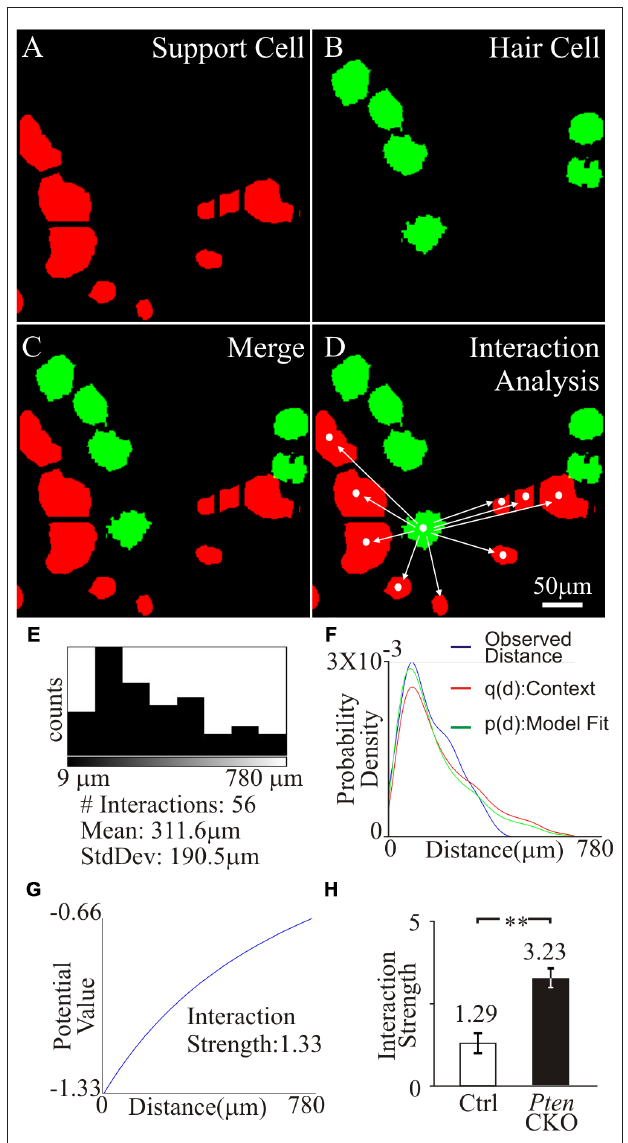
FIGURE 7 | Interaction strength of supporting cell and surviving hair cells. Region containing tdTomato+supporting cell and MYO7A+ tdTomato- hair cells were analyzed. (A) Supporting cell masks were generated from tdTomato labeled supporting cells (red). (B) Hair cell masks were generated from MYO7A labeled hair cells (green). (C) Merged image of supporting cell and hair cell masks. (D) Centroid of hair cell and supporting cells were generated from masks. Distance between an individual hair cell centroid to all supporting cell centroids in the field of view was determined. (E) Number of cell interactions within a field of view and the mean distance between the centroid of a hair cell to multiple supporting cells was displayed in the histogram. (F) The observed distances between a hair cell and supporting cells were fitted into probability density, p(d), and an interaction potential model, q(d). (G) Interaction strength between hair cell and supporting cells was calculated from the interaction potential q(d). (H) Comparison of the interaction strength between surviving hair cells and control supporting cells ( n = 10) or surviving hair cells and Pten cKO supporting cells ( n = 10) after cisplatin treatment. Statistical significance was determined using the Student’s t -test and error bars in